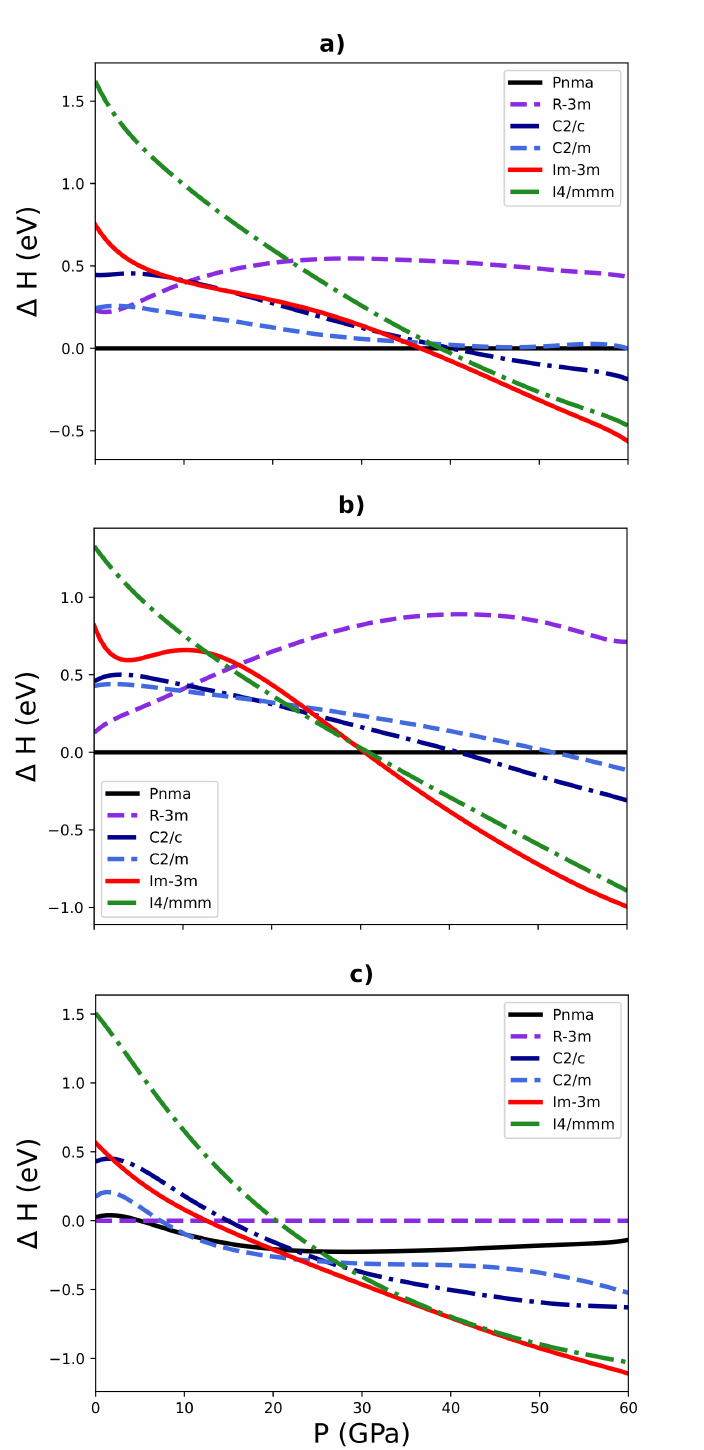
Figure 2. Calculated relative enthalpy vs. pressure curves, for the different possible phases (shown in Figure 1) of Sb 2 S 3 ( a ), Bi 2 S 3 ( b ), and Sb 2 Se 3 ( c ), relative to the lowest-energy phase at ambient pressure: the Pnma phase for Sb 2 S 3 and Bi 2 S 3 , and the R-3m phase for Sb 2 Se 3